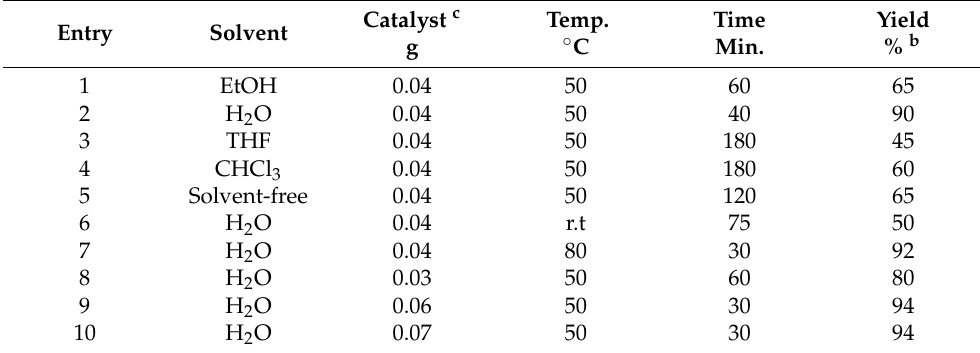
Table 2. Optimization of the three-component reaction of 3-methyl-1-phenyl-1 H -pyrazol-5-ol, ben- zaldehyde, and 2-hydroxy naphthoquinone under various conditions a .